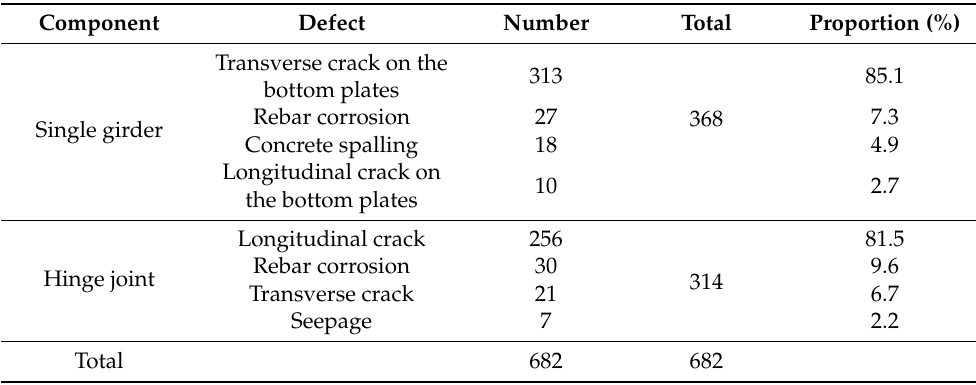
Table 5. Surface damage at different